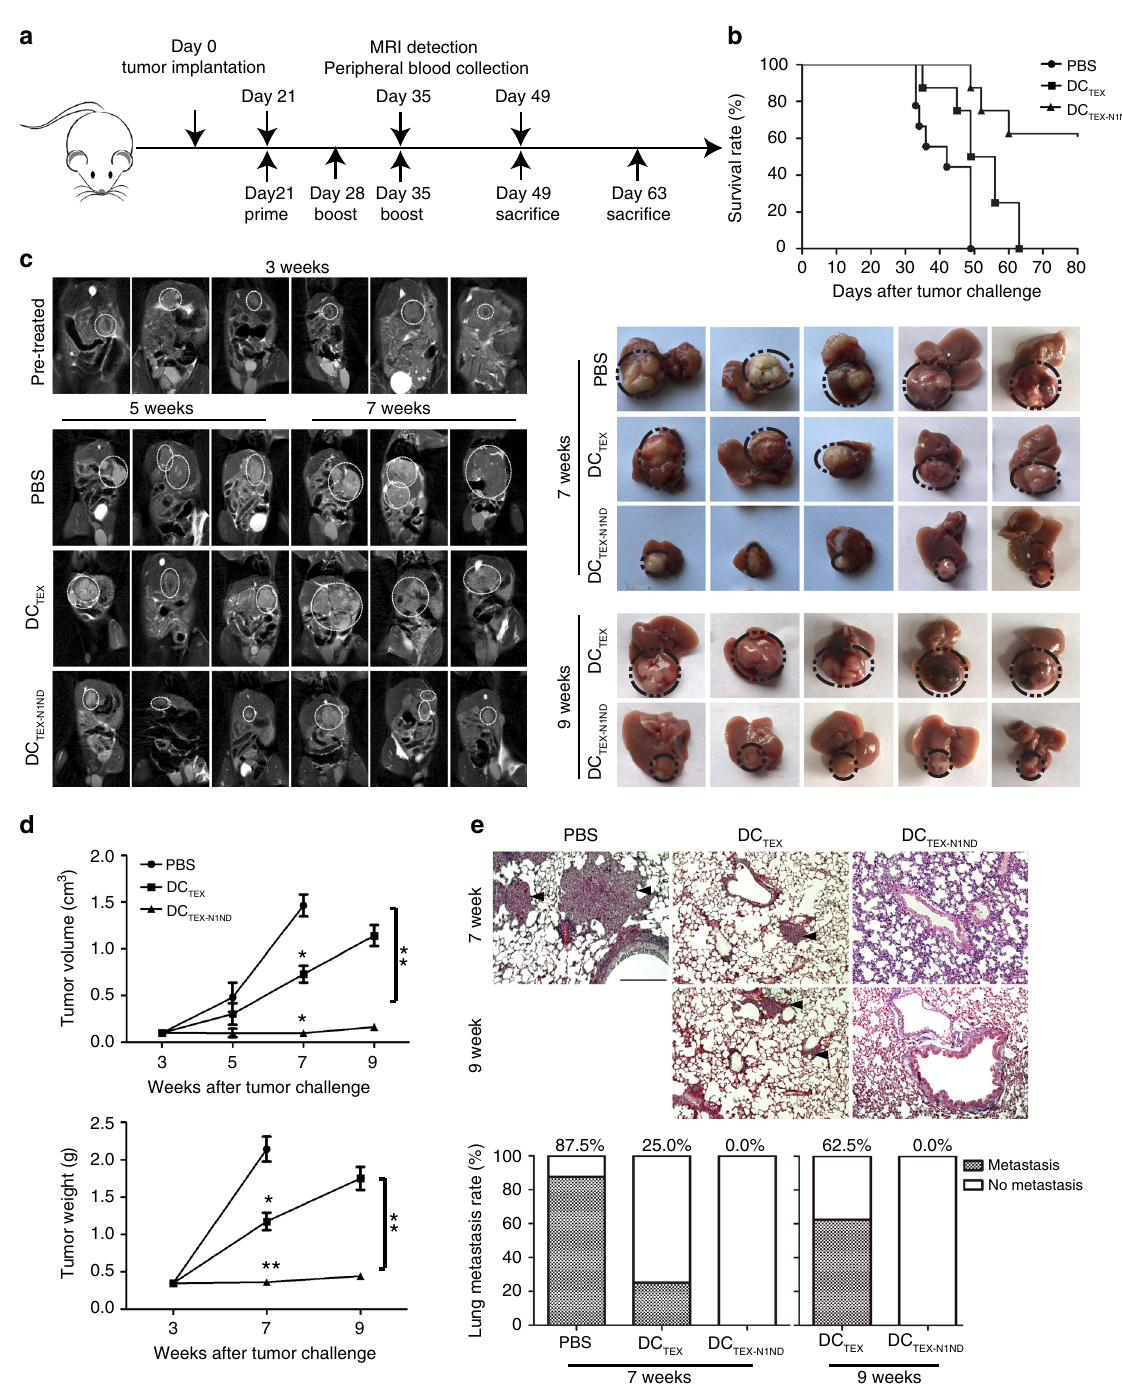
Fig. 3 Antitumor effect of DC TEX-N1ND in orthotopic HCC mice (H-2 b ). Day-21 orthotopic C57BL6 HCC mice were intravenously treated with